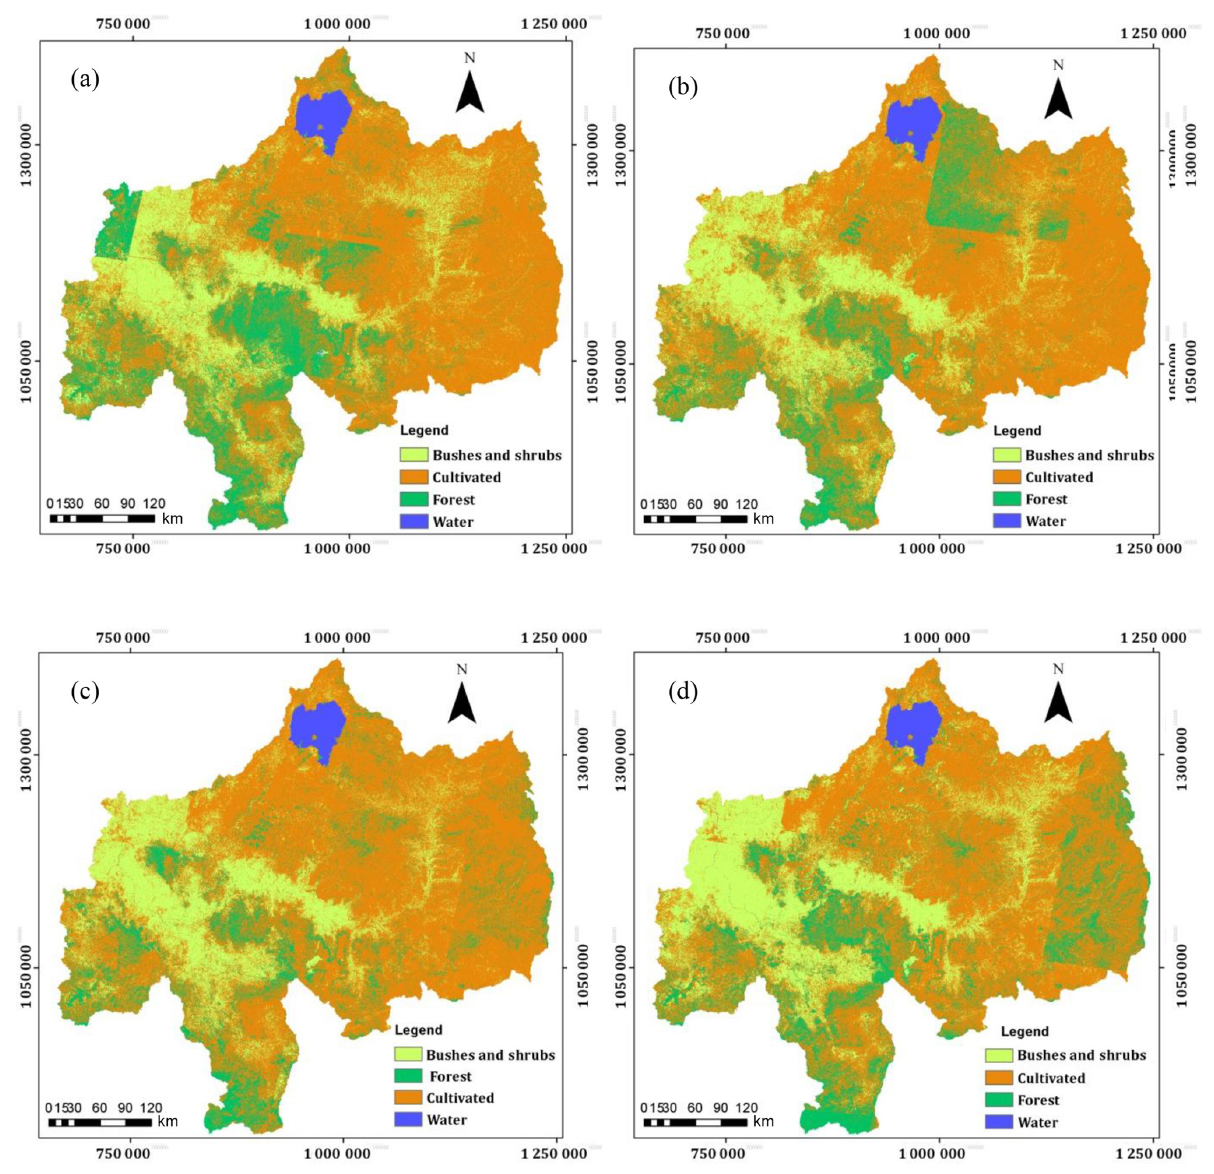
Figure 4. Land-cover map of UBNRB derived from Landsat images from (a) 1973, (b) 1985, (c) 1995, and (d) 2010a (b)